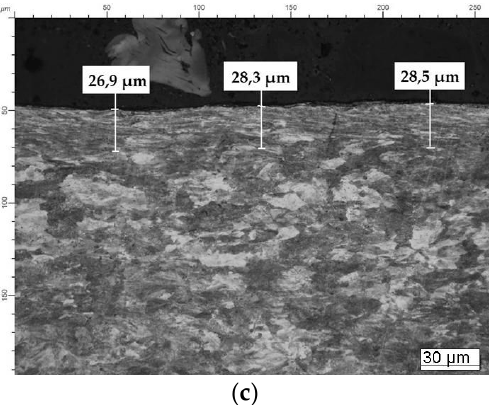
Figure 7. Thickness of the fine grain layer after drawing through α = 4 deg die: ( a ) soft friction condition; ( b ) medium friction condition; and ( c ) hard friction condition.